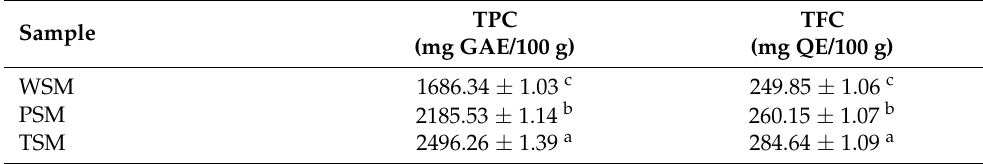
Table 3. Phenolic content and flavonoid content in the sunflower meals analyzed.